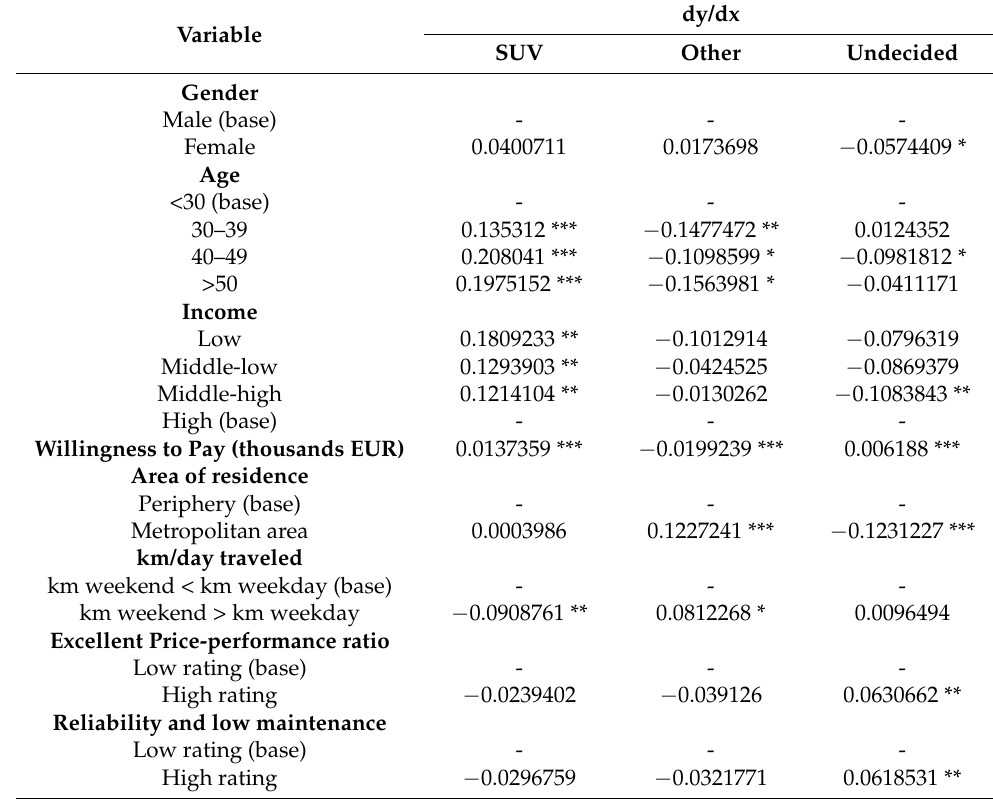
Table 6. Average marginal